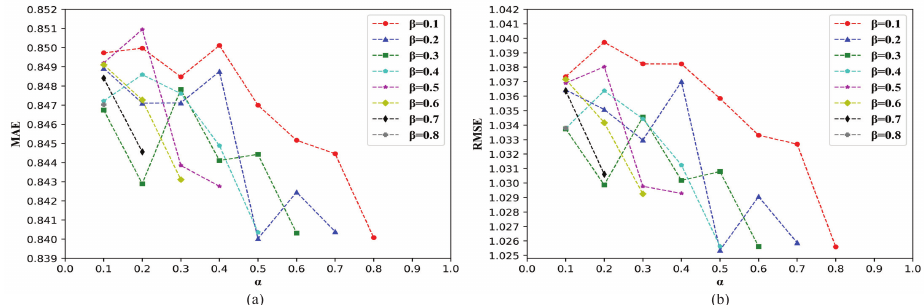
Figure 7. The influence of the user characteristic parameters α , β , and δ on the proposed method. ( a ) of MAE; ( b ) of